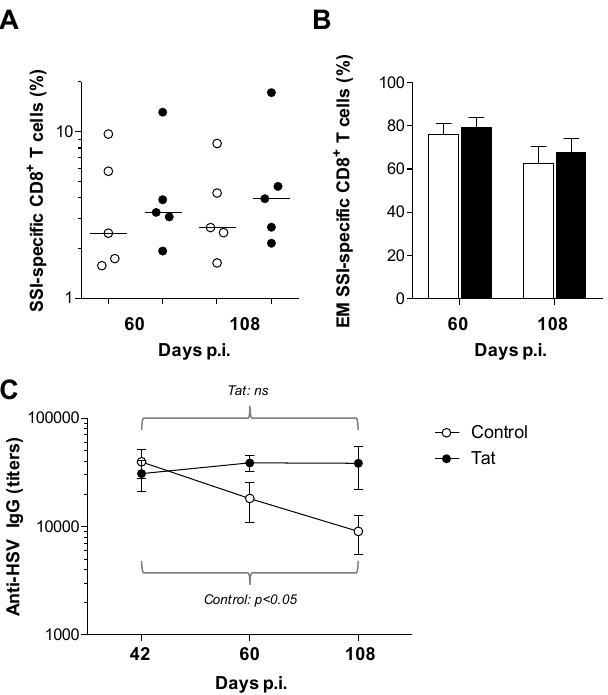
Figure 2. Tat improves the maintenance of previously established immune memory responses. ( A ) Analysis of SSIEFARL (SSI)-specific CD8 + T cells. Blood was collected from the retro-orbital bleeding of mice (n = 5 per group) at days 60 and 108 p.i. (days 16 and 64 after bu ff er ± Tat inoculation, respectively) to determine the percentage of SSI-specific CD8 + T cells. Dots represent the results of single mice and lines represent median values. ( B ) Analysis of e ff ector memory (EM) SSI-specific CD8 + T cells. The percentage of peripheral blood circulating EM (CD44 + CD62L − ) cells within the SSI-specific CD8 + T lymphocyte pool was measured at days 60 and 108 p.i. (days 16 and 64 after bu ff er ± Tat inoculation, respectively). Bars represent the mean ± SEM ( n = 5 per group). ( C ) Analysis of anti-HSV-1 antibody responses. Sera were collected at days 42, 60 and 108 p.i. (two days before bu ff er ± Tat treatment, and days 16 and 64 after bu ff er ± Tat inoculation, respectively) to assess the presence and titers of HSV-specific IgG. Dots represent the mean ± SEM ( n = 5 per group). A paired Student’s t test was used to estimate the changes over time in HSV-specific IgG titers. n.s. = not